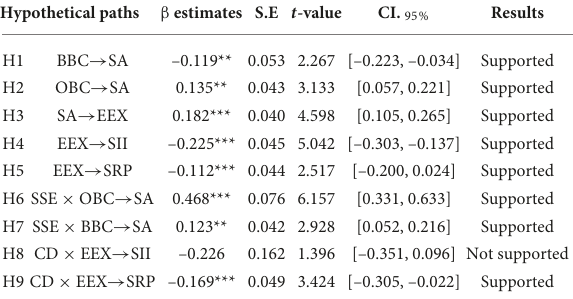
TABLE 4 Results of